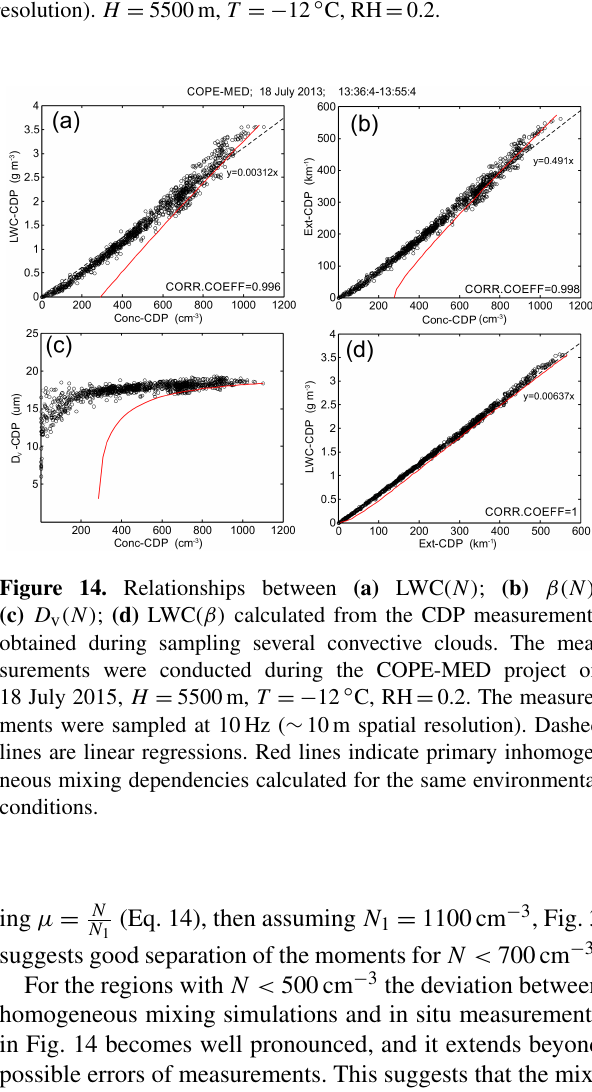
Figure 13. Spatial changes of particle concentration (a) , extinction coefficient (b) , liquid water content (c) and average and mean mass diameter (d) during transit through one of the convective clouds measured by CDP. The measurements were conducted during the COPE- MED project on 18 July 2015. The sampling rate 10Hz ( ∼ 10m spatial resolution). H = 5500m, T = − 12 ◦ C, RH = 0.2.